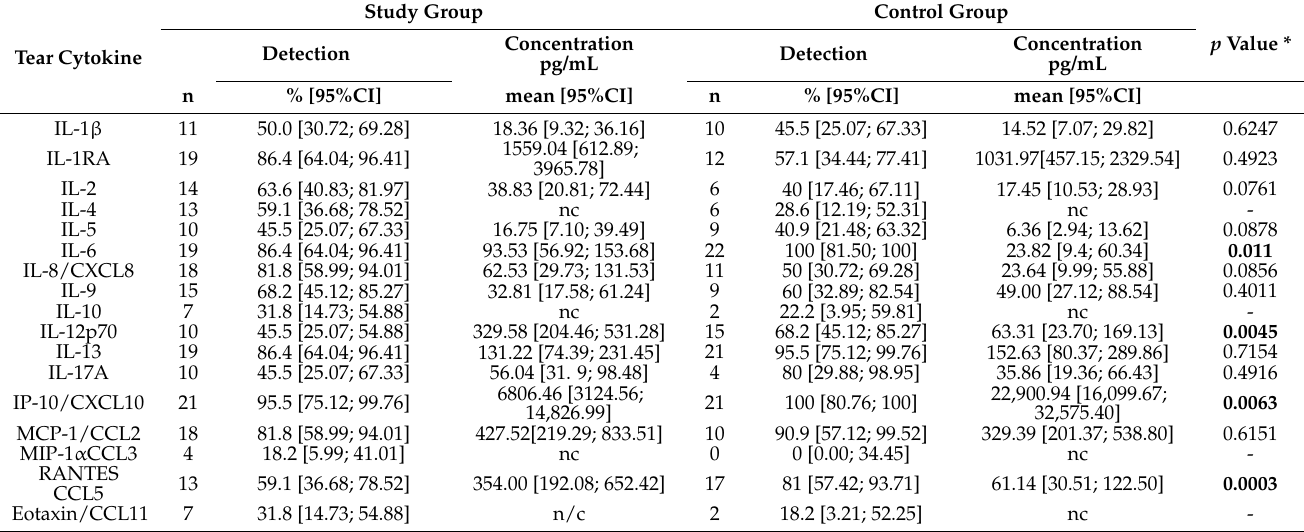
The percentage of detection and concentration for each tear cytokine is shown in Table 5. Eotaxin, IL-10, IL-4, and MIP-1 α were not statistically analyzed any further due to the very low percentage of detection (<30%). For the remaining cytokines, there were no differences in the percentage of detection between the 22 patients and the 22 healthy controls. Table 5. Percentage of detection and concentration of molecules analyzed in tears of the mercury-intoxicated patients and the healthy